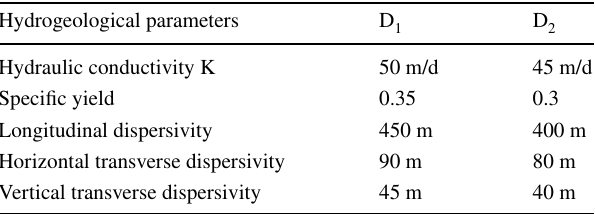
Fig. 1 General situation and parameter regionalization of research area Table 1 Hydrogeological parameter table of research